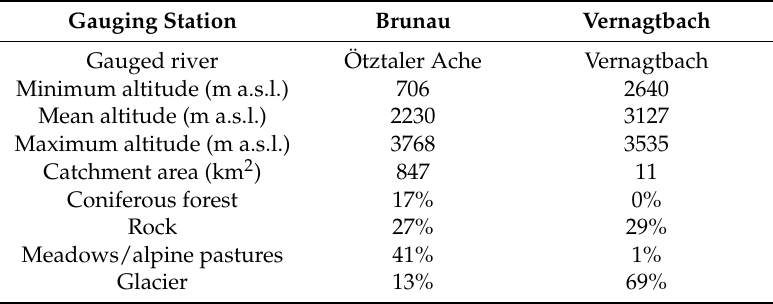
Figure 1. Map of the study area with location of the gauging stations, catchment boundaries, glacier coverage and closest meteorological stations. Table 1. Main characteristics of the investigated catchments.